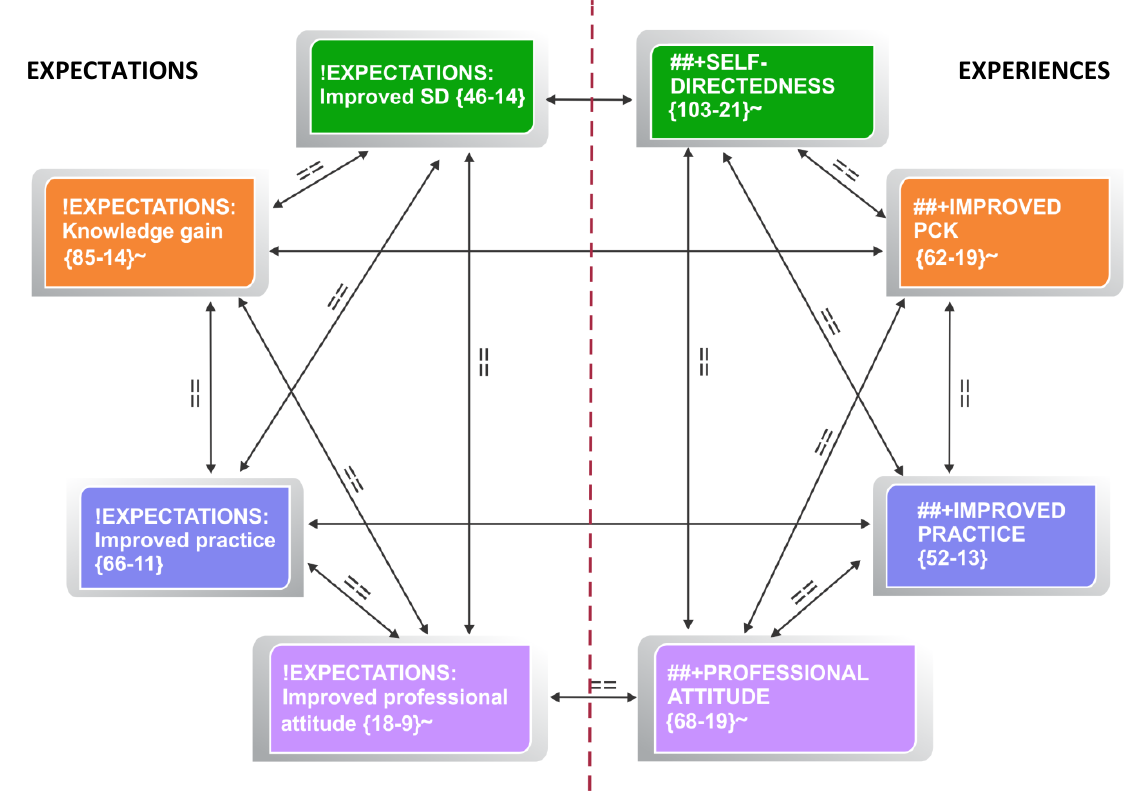
Figure 4. Comparing expectations with experiences with regards to core elements of applied